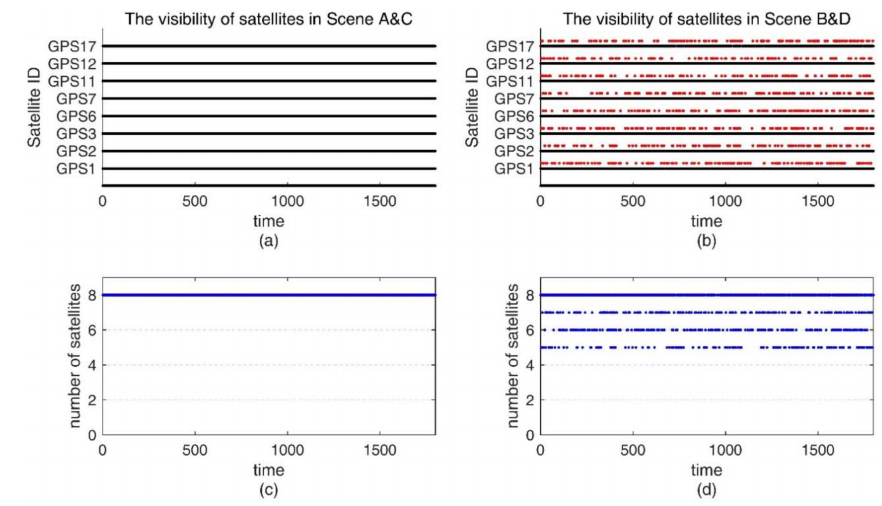
Figure 7. ( a ) The satellite visibility of the 1800-s simulation data for the control group; ( b ) The satellite visibility for experimental group; ( c ) The number of satellites in Scene A and C; ( d ) The number of satellite in Scene B and D.